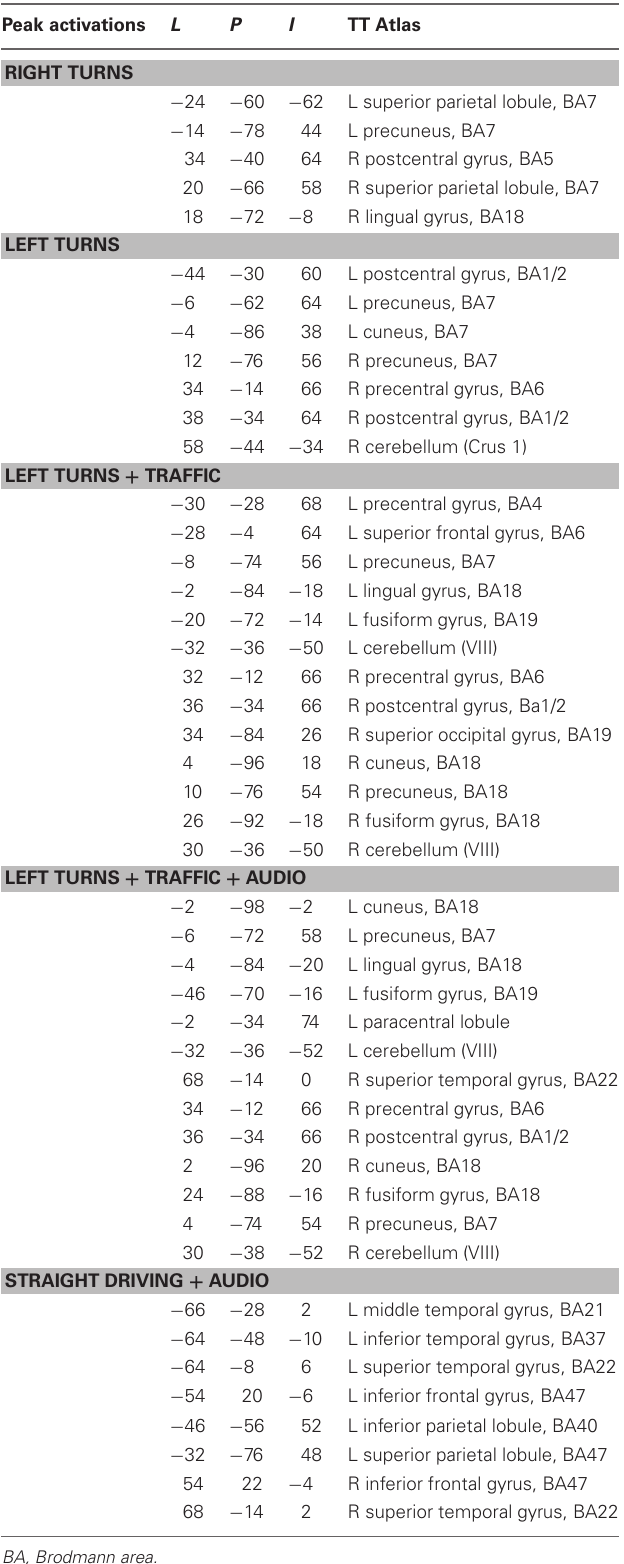
Table 1 | Peak locations (Tailarach coordinates) of brain activations during each driving